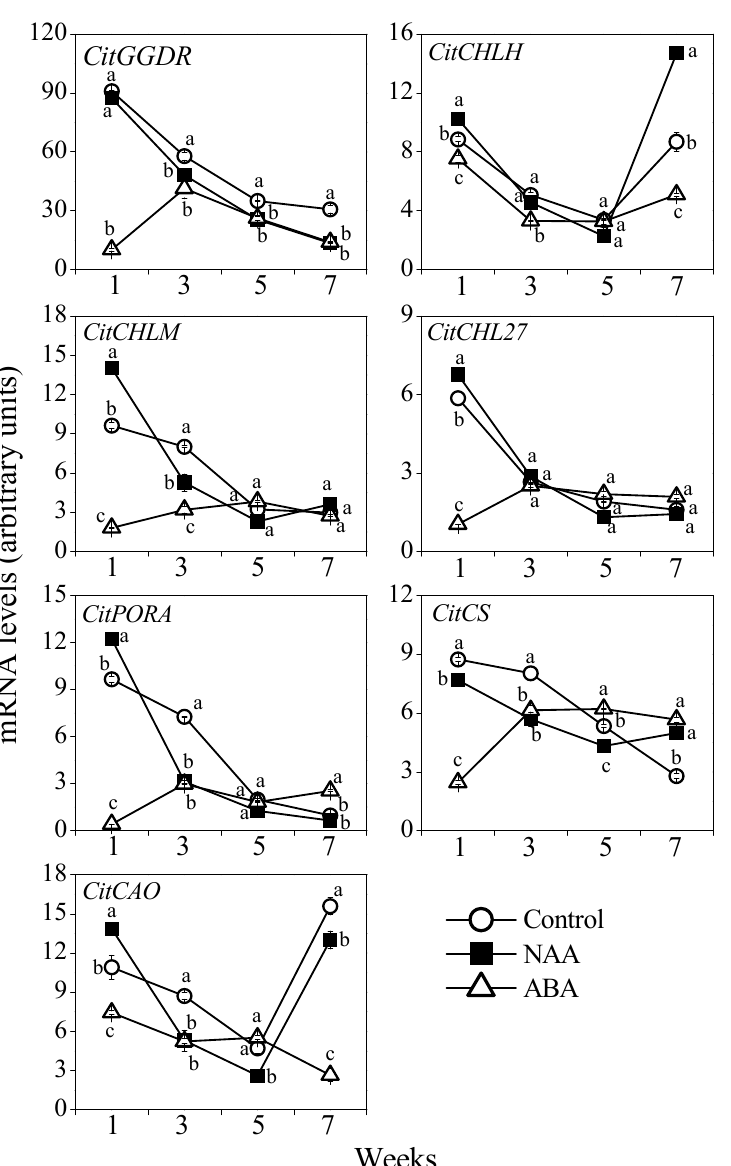
Figure 5. Effect of NAA and ABA on the expression of chlorophyll biosynthetic genes in the flavedo of GA and PDJ-treated citrus fruit. The mRNA levels were analyzed by TaqMan quantitative RT-PCR. RT-PCR amplification of 18S ribosomal RNA was used to normalize the expression of the genes under identical conditions. The results shown are the mean ± SE for triplicate samples. Different letters (a, b, and c) indicate significant differences at the 5% level by Tukey’s test.